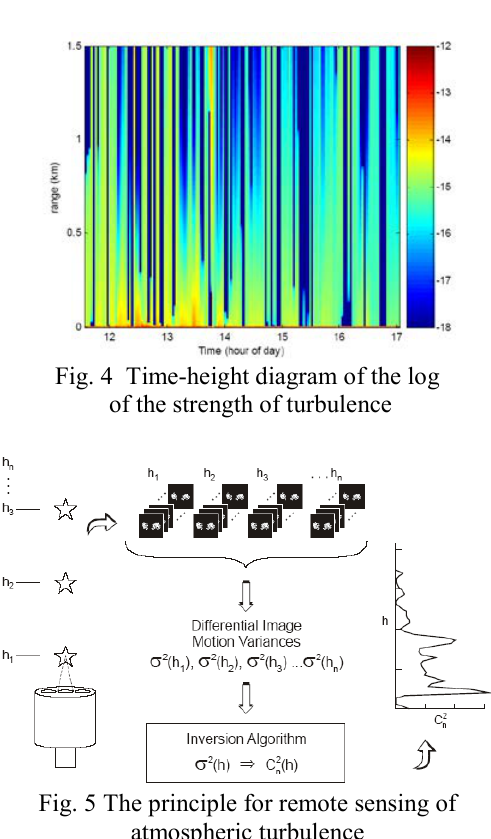
Fig. 3 example of Differential Image Motion versus camera frame number